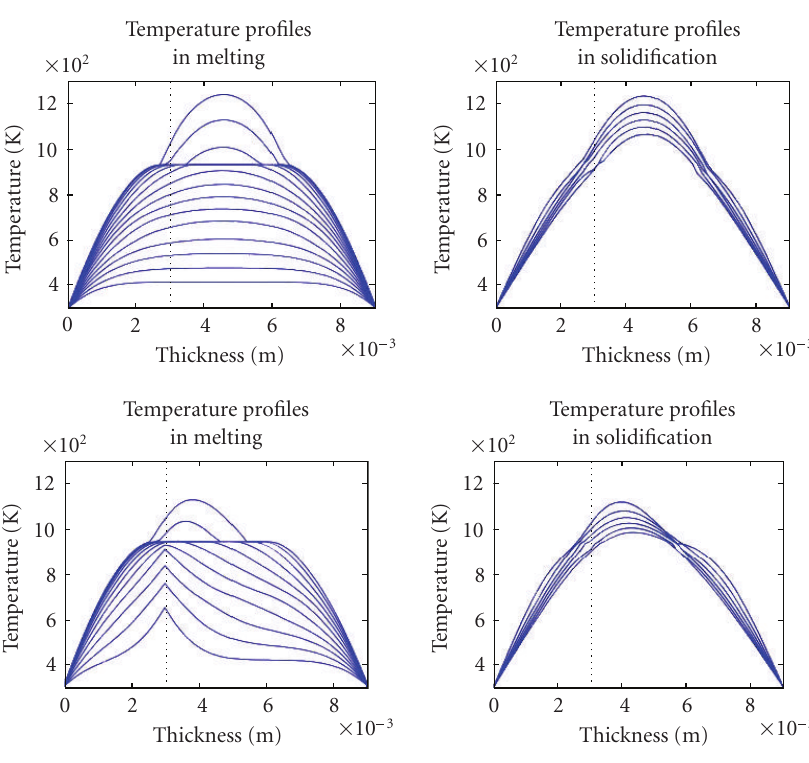
Figure 4.7. Example 2: spatial and temporal variation of temperature for R g = 0 (top), R g = 10 − 9 initially (bottom). The curves represent equal time increments. Dotted line indicates location of in-